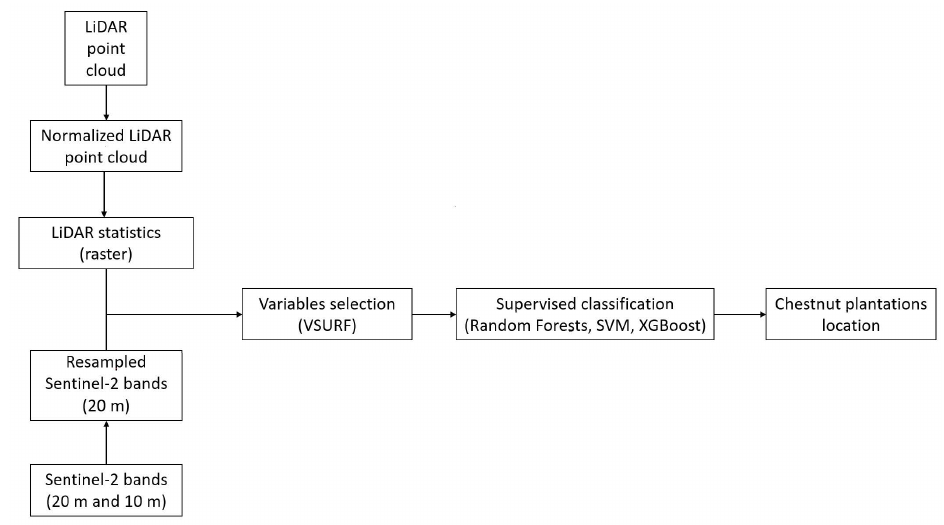
Figure 4. Procedure followed for the detection of chestnut ( Castanea sativa ) plantations detection.